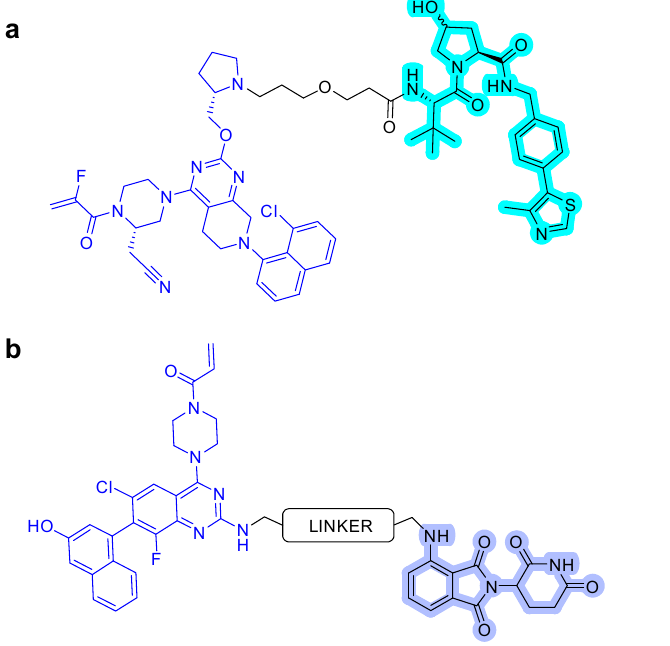
Figure 6. KRAS degrader. ( a ) LC-2 , MRTX849-VHL PROTAC. ( b ) ARS-1620-CRBN PROTAC. The colors show the part of each compound that it is a structurally important binding motif. The ligands of the POI are in blue. VHL and CRBN ligands are highlighted in cyan and purple, respectively.